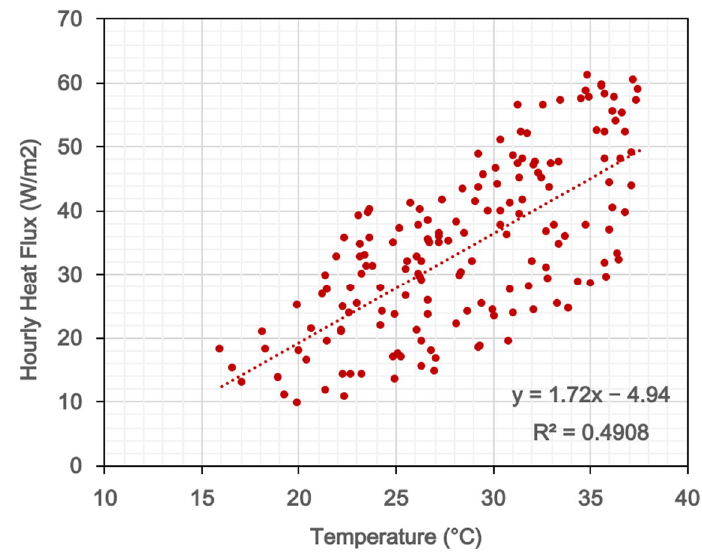
Figure 13. Heat flux versus outdoor air temperature.